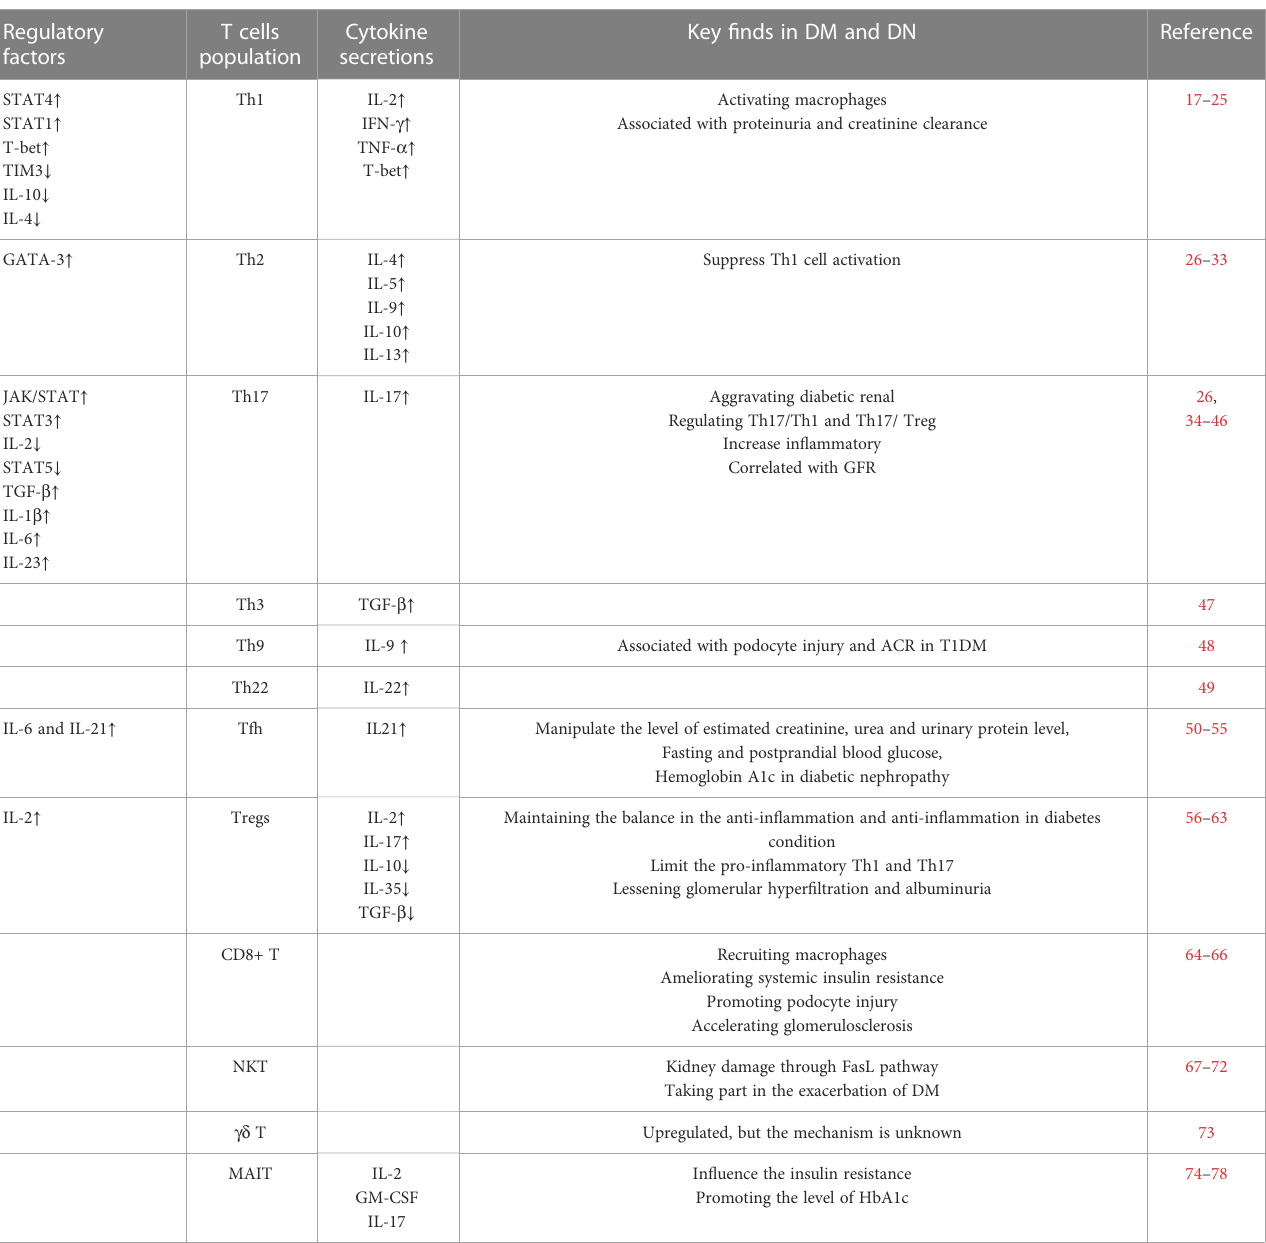
TABLE 2 The fundamental function of T cells in DM and